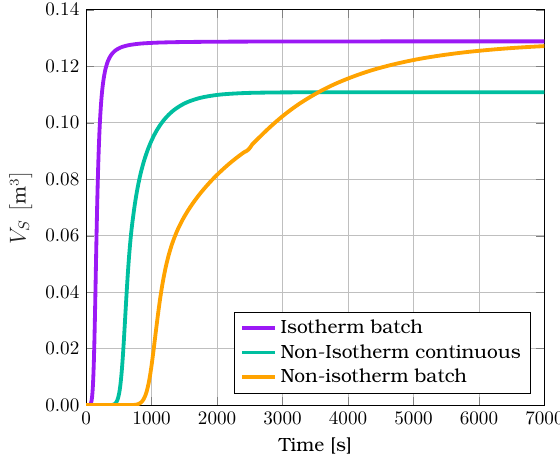
Figure 15. Change in V S in the three